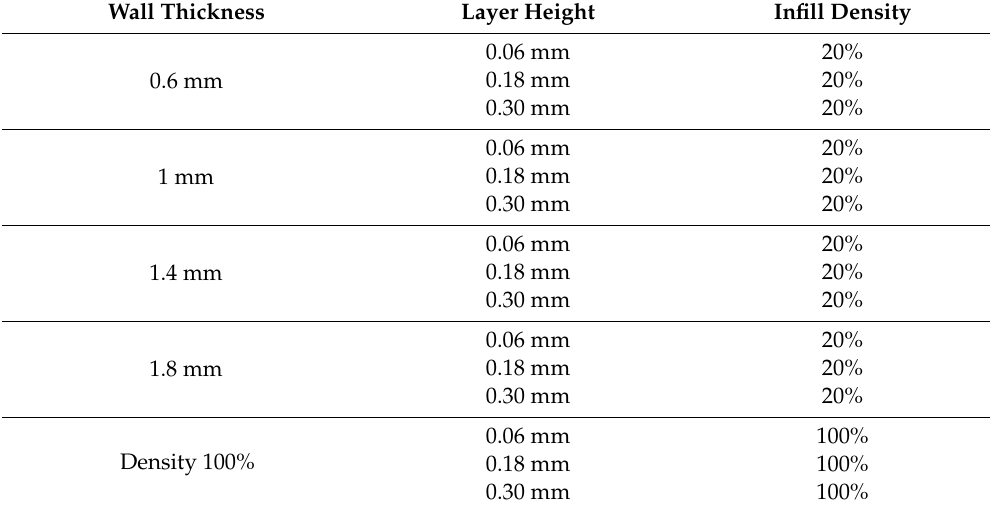
Table 3. Groups of samples manufactured with di ff erent printing